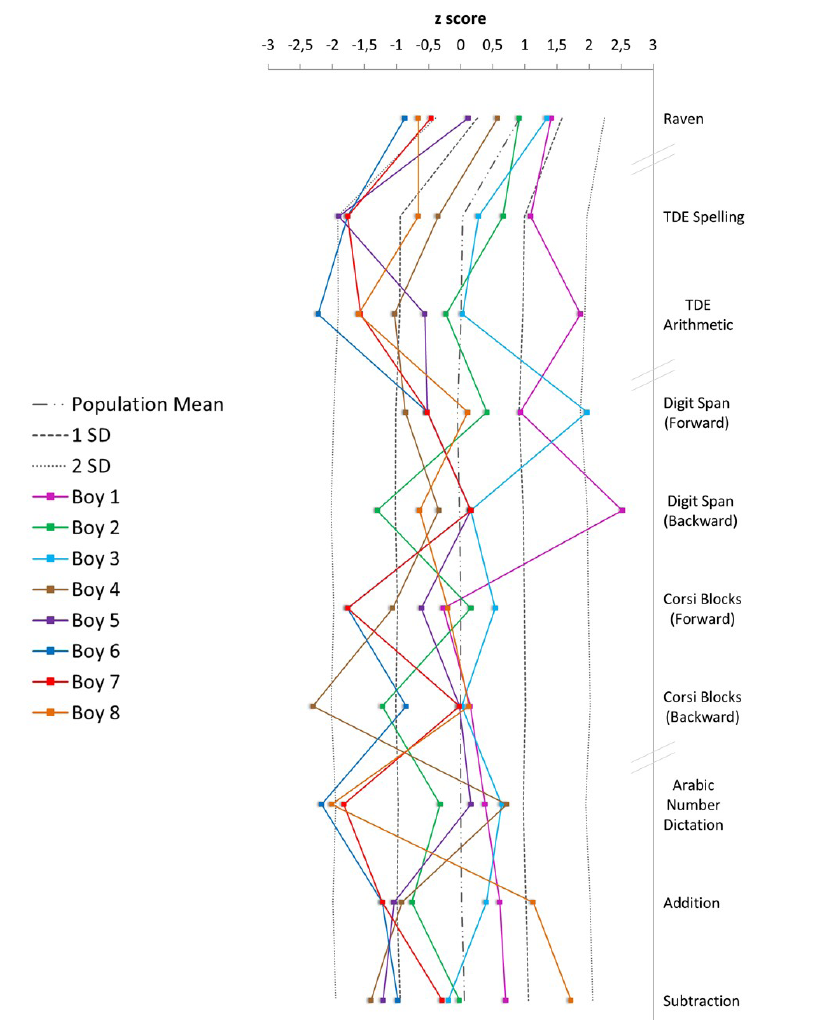
Figure 1. Quantitative results of the neuropsychological assessment for each boy having the MAOA_LPR*2R